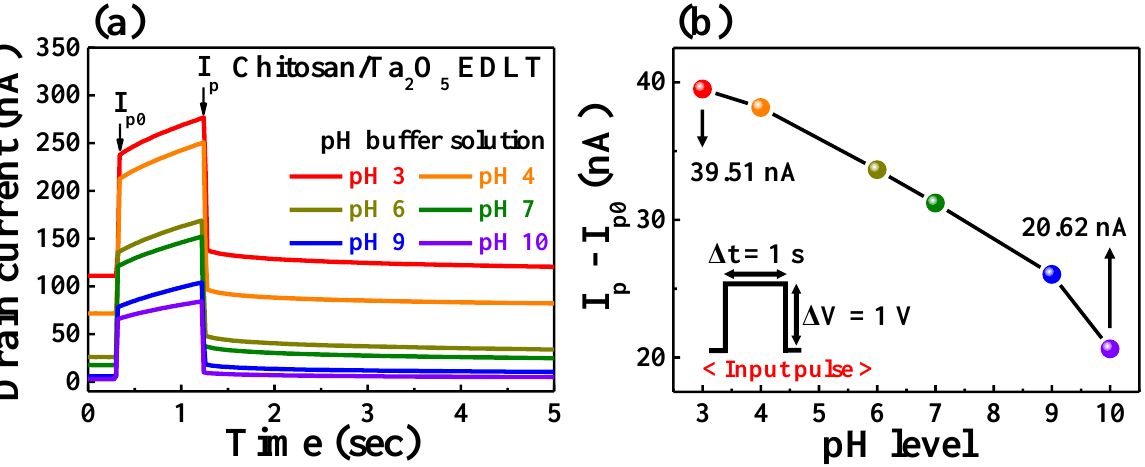
Figure 5. ( a ) Dynamic I D response in various pH buffer solutions; ( b ) pH-dependent changes in I D (I p − I p0 ) at a gate pulse (1s duration) of the chitosan/Ta 2 O 5 hybrid dielectric EDLT.